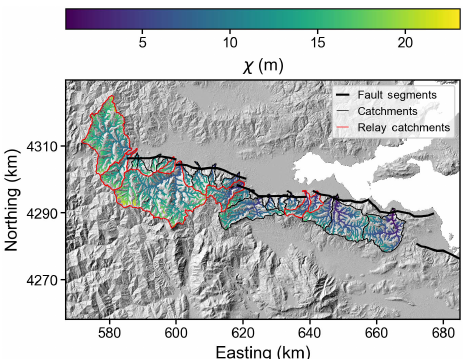
Figure 14. Spatial distribution of the χ coordinate in the chan- nel network calculated using A 0 = 1m 2 ; θ = 0.45. Gradients in χ across topographic divides (black) can indicate planform disequilib- rium such that the drainage network may be reorganising. Divides will tend to migrate from low values of χ towards high values in the channel